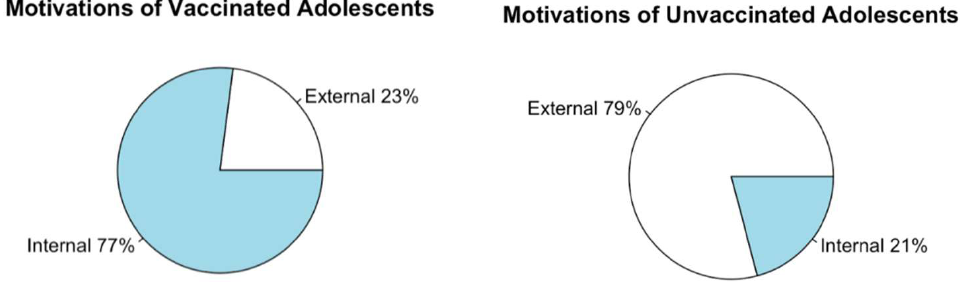
Figure 2. Valence of adolescent vaccination motivation by vaccination status.